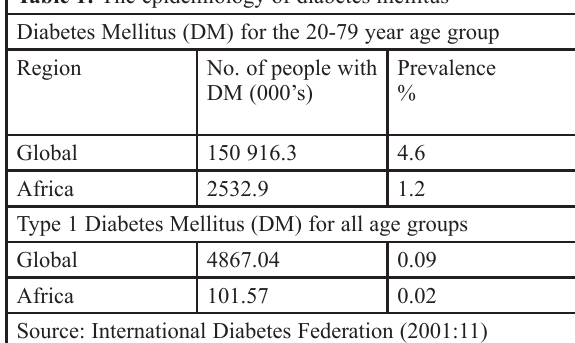
Table 1: The epidemiology of diabetes